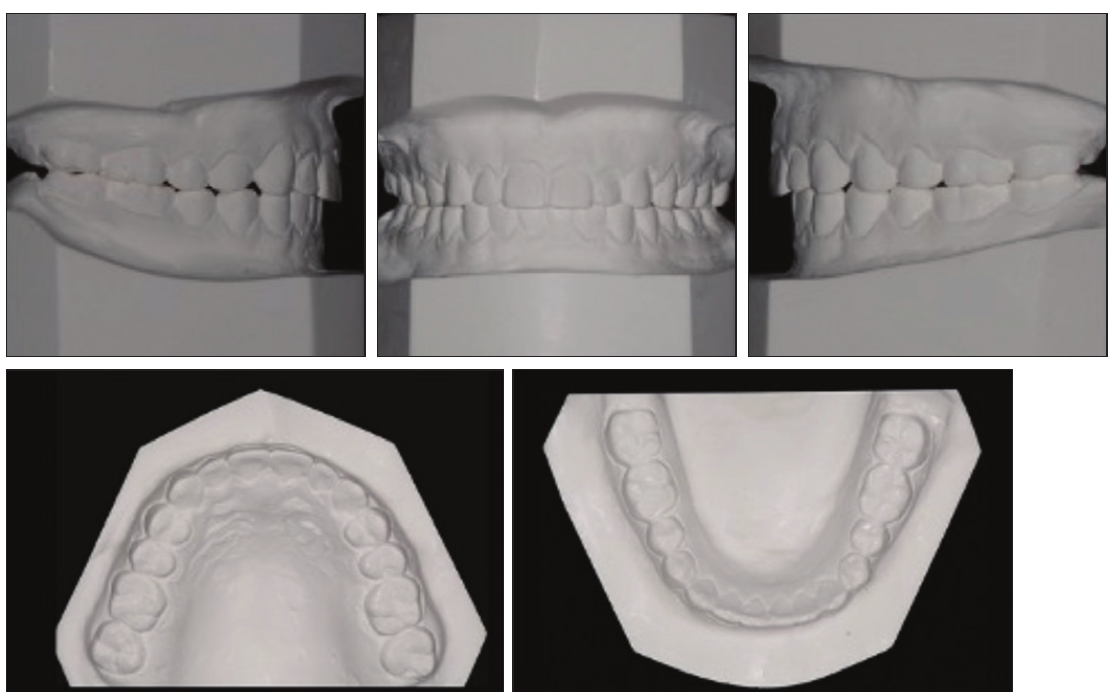
Figure 7. Post-treatment dental